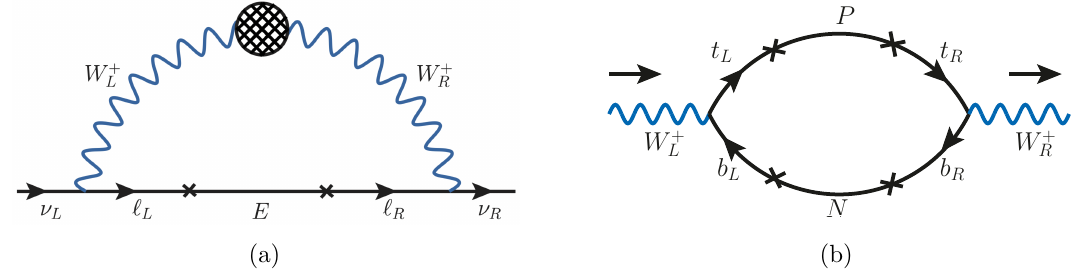
Figure 1. Left: one-loop finite Dirac neutrino mass generated via the mixing shown in figure (b). Right: one-loop diagram that induces mixing between W +